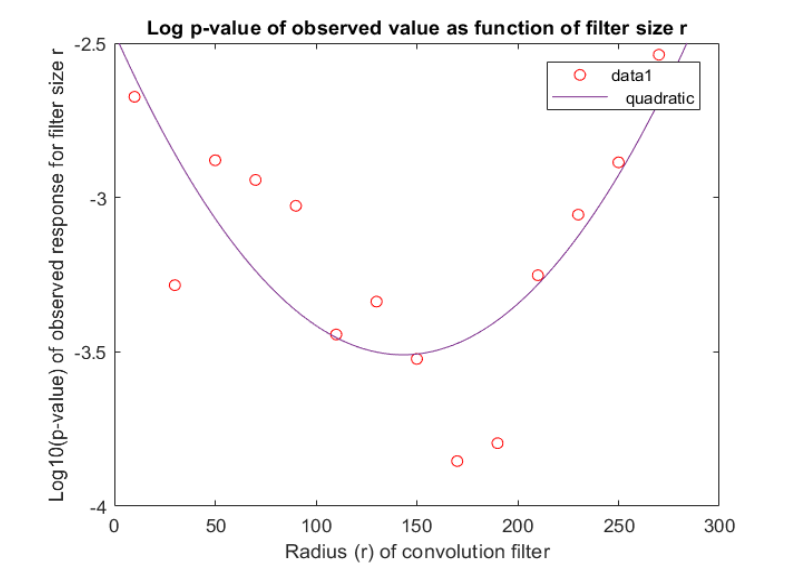
Figure 4. Log 10 p -value of observed response T ( r ) as function of r . From this graph, we conclude that r = 150 is a reasonable choice for the filter size. The p -value for each r is based on 50,000 MC paths.